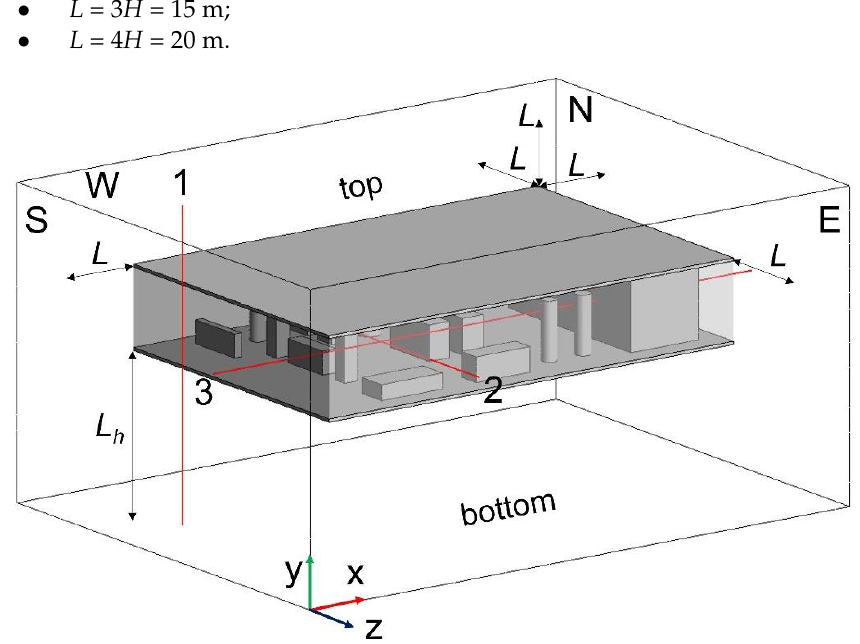
Figure 2. External box for the wind simulation with probe lines (in red). The letters S, E, W, N indicated the lateral sides of the box while the other two faces are named top and bottom .